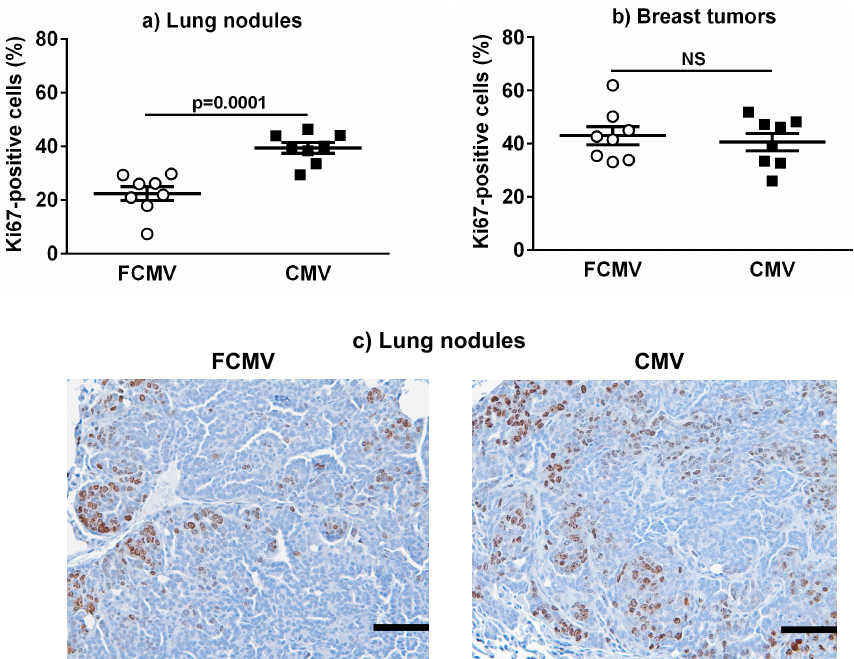
Figure 5. Cancer cell proliferation was enhanced in lung metastatic nodules but not in the breast tumors from MMTV-PyVT mice latently infected with mCMV. Lung metastatic nodules ( a ) and breast tumors ( b ) from mice treated with a filtered control (FCMV) or mCMV (n = 8) were stained for Ki67 to assess cell proliferation. The representative stained sections of lung nodules from FCMV- and mCMV-treated mice are illustrated ( c ). The image was taken with a 20 × magnification lens. Scale = 100 µ m. The p -values were calculated by Student’s t -test. NS = not significant.